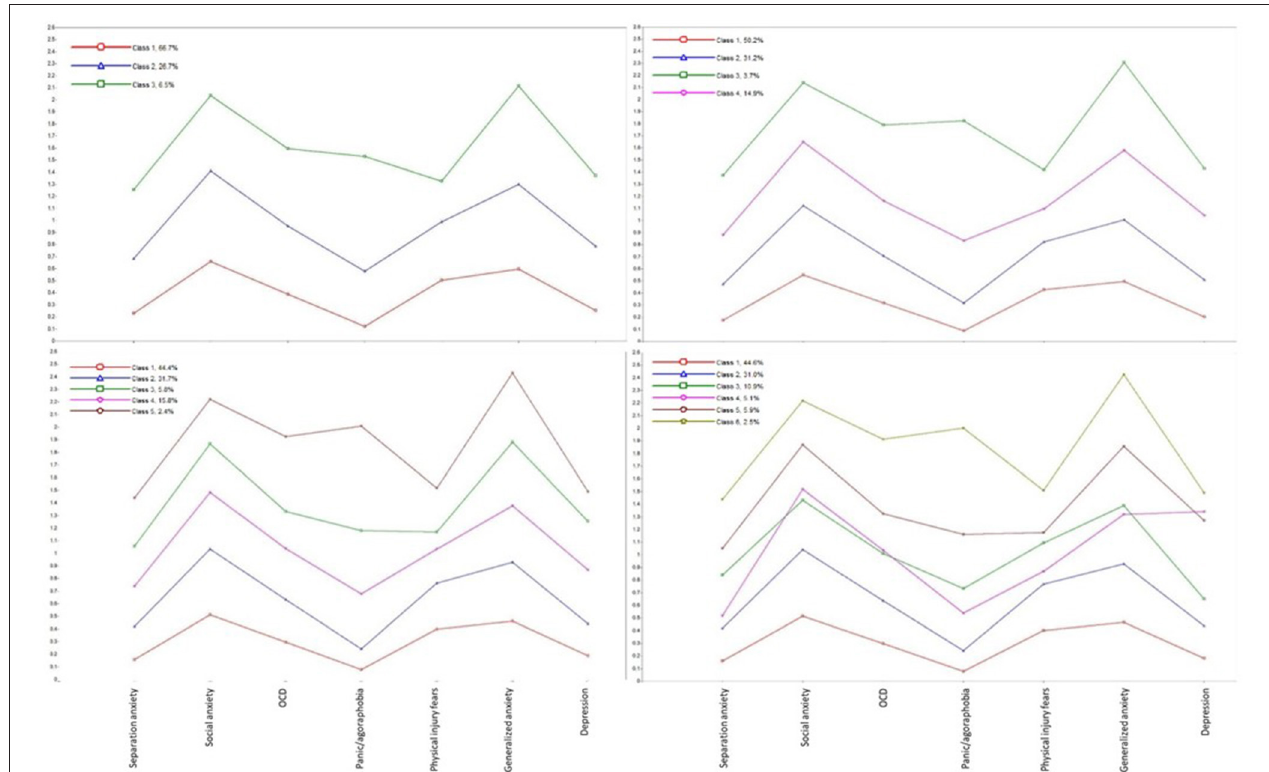
FIGURE 3 | Three, four, five, and six latent profiles on internalizing symptoms across a foster care, clinical, and general population youth samples. From the top-left corner: three-symptom profile (final model solution) and four-symptom profile. From the bottom-left corner: five-symptom profile and six-symptom profile. The internalizing symptoms are represented at the bottom two profiles as separation anxiety, social anxiety, obsessive–compulsive disorder, panic/agoraphobia, physical injury fears, generalized anxiety, and depression